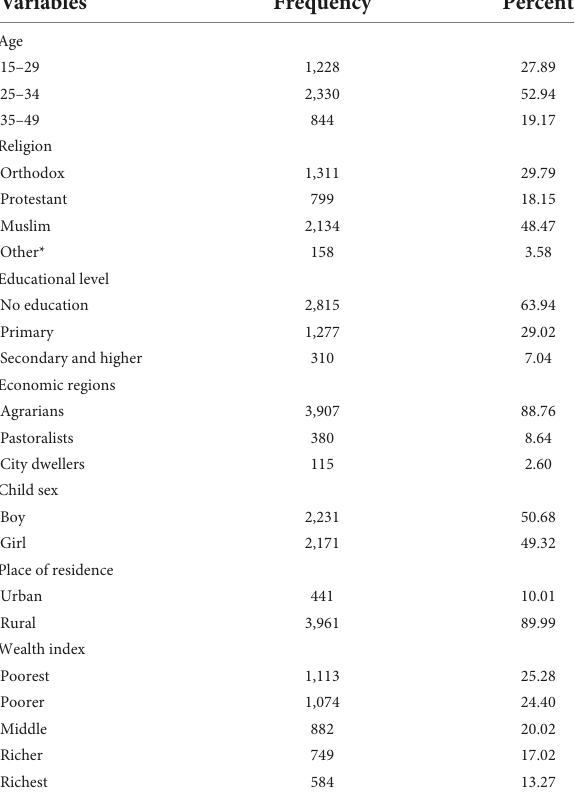
TABLE 1 Sociodemographic characteristics of mothers in Ethiopia, 2016.